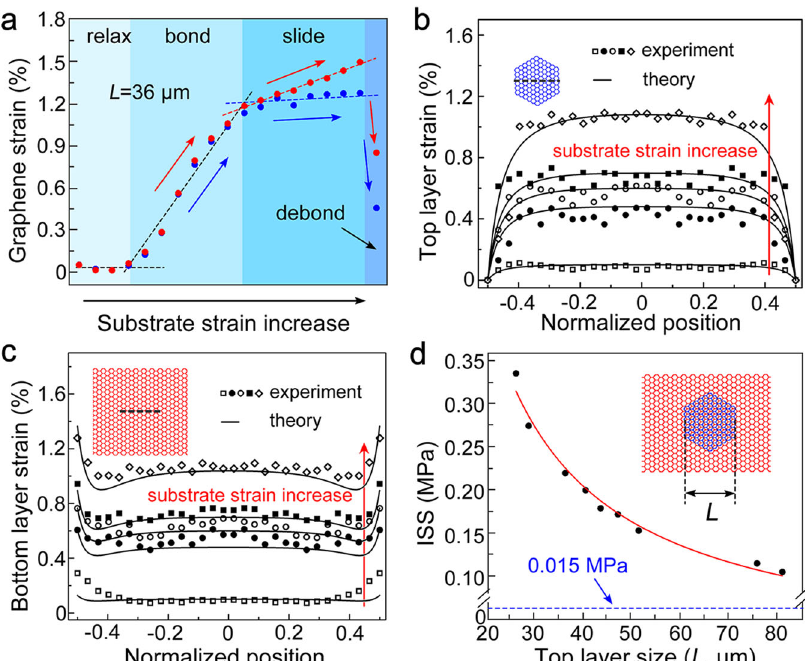
Fig. 2 Interfacial behaviors of AB-BLG probed by Raman spectroscopy. a Strain evolution of the top and bottom layers for an AB-BLG with substrate stretching. b , c Strain distributions along the tensile direction in the top and bottom graphene layers, respectively. d Calculated ISS of BLG as a function of its top layer size. The ultimate ISS value is fi tted from the inverse proportionality of the data and indicates the ISS governed purely by vdW interaction for an in fi nite-sized